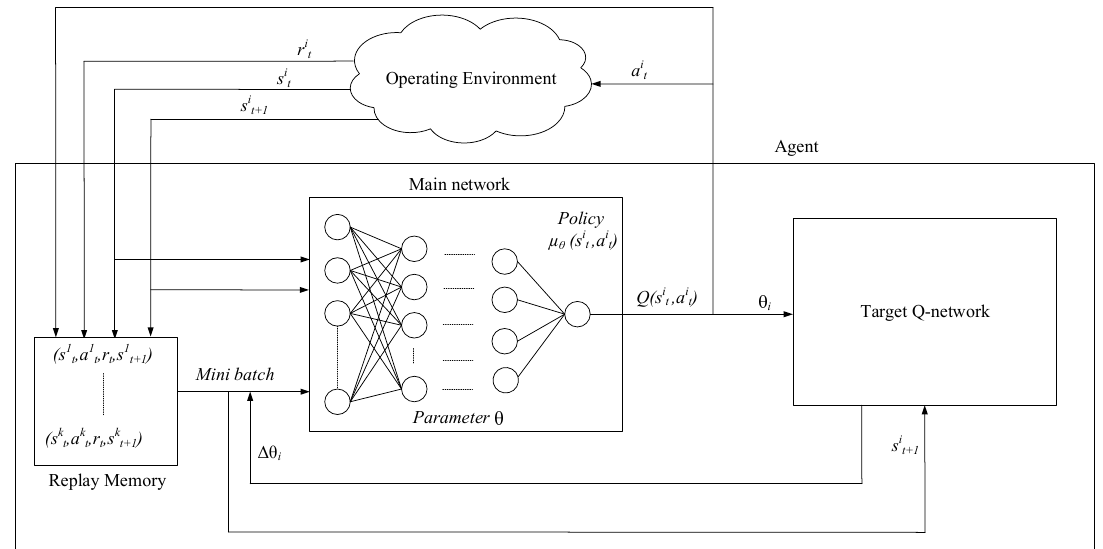
Figure 3. An overview of DQN. Main network, characterized by main network parameters θ i , provides Q-value Q ( s t target network parameters ¯ θ i , generates target Q-value Q ( s t are used to calculate a loss function L i ( θ i ) minimized using the gradient descent approach during training. Experiences ( s k training. A mini batch of random experiences from the replay memory are fed into the main and target networks. The DQN agent is incorporated in CC as shown in Figure